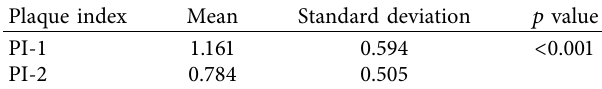
Table 2: Comparison of the dental plaque index before and after the educational